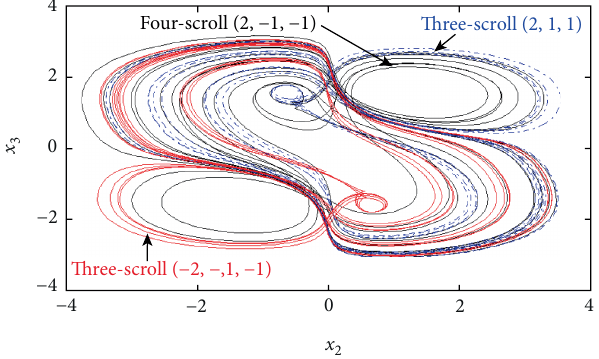
Figure 4: Coexisting two kinds of three-scroll, four-scroll chaotic attractors in fractional-order memristive system (2).